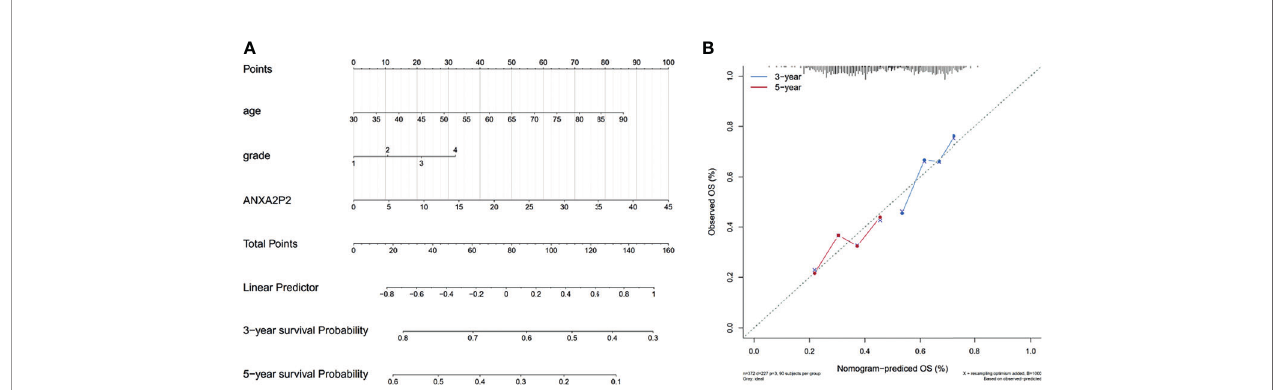
FIGURE 10 | Nomogram prediction model for ANXA2P2 in OV. (A) The model of relevant nomogram chart, with different lines meaning different clinical features of the sample. (B) The corrective curve of the correlative nomogram chart, with blue for 3 years and red for 5